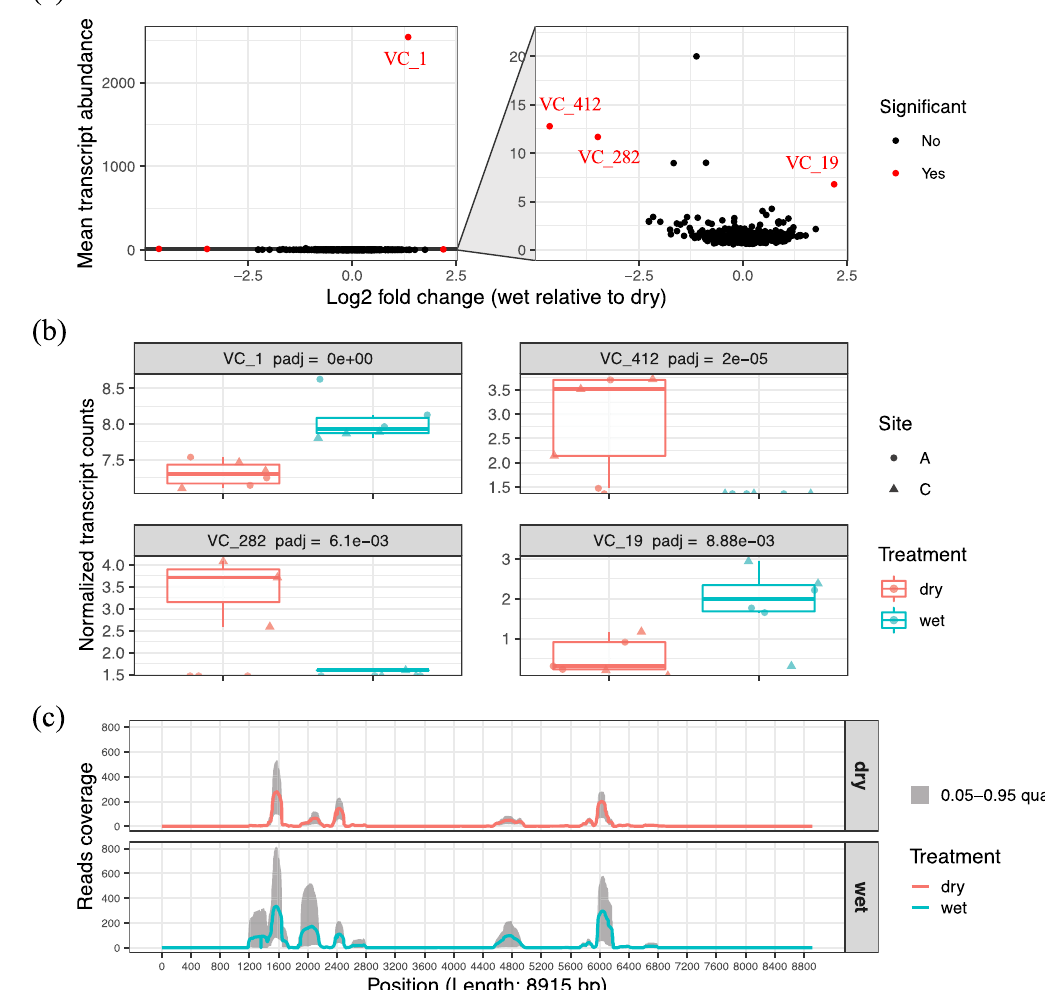
Fig. 2 DNA viral contigs with differential transcription in wet and dry soil treatments. a Transcript abundance pro fi ling of the identi fi ed DNA viral contigs. The mean transcript abundance of each DNA viral contig detected in all soils was plotted along the y axis in the sub-panel on the left. The normalized transcript abundances of each DNA viral contig were compared across treatments (wet and dry soils) and transformed into log 2 fold change (wet relative to dry). The viral contigs with signi fi cantly differential transcript counts across treatments ( p < 0.05) are highlighted in red in the sub-panel on the left. A zoomed-in panel on the right shows the viral contigs with lower transcript counts. b Four DNA viral contigs that were detected with differential transcript abundances in wet (blue) and dry (red) soils are shown. c Quality- fi ltered metatranscriptomic read coverage for the VC_1 sequence (total length of 8915 bp); the sequence with the highest number of transcripts mapped in ( a ). The solid line represents the mean read coverage per position detected in all replicates for each treatment (red = dry soil; blue = wet soil). The gray shading shows the range of read coverage distribution per position (0.05 – 0.95